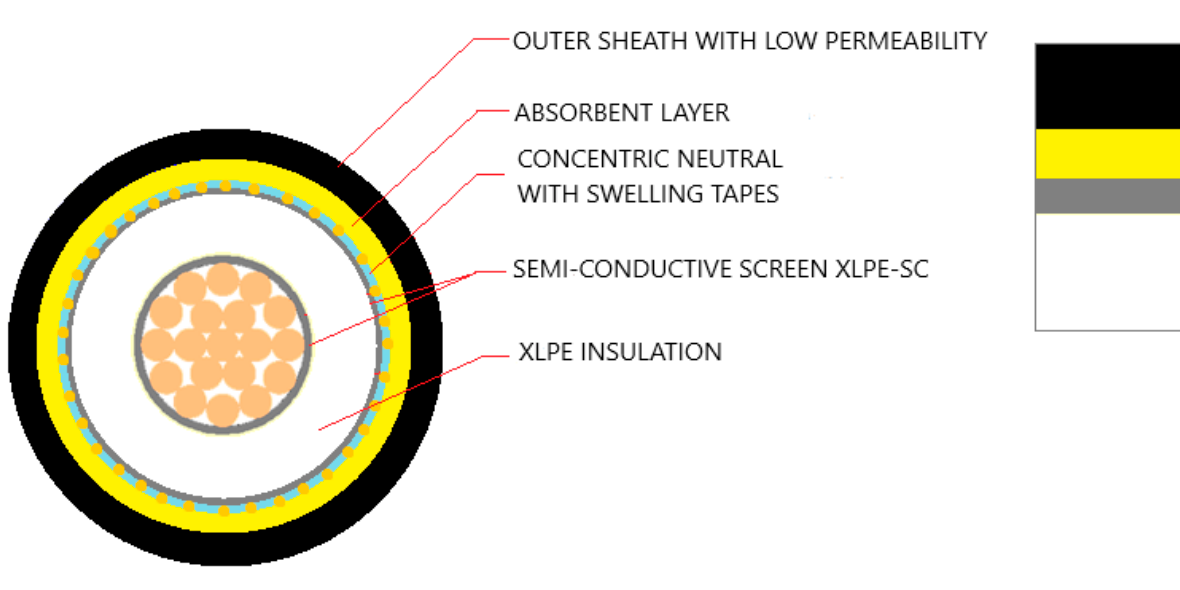
Figure 6. Cross-section of a cable with absorbing layer.